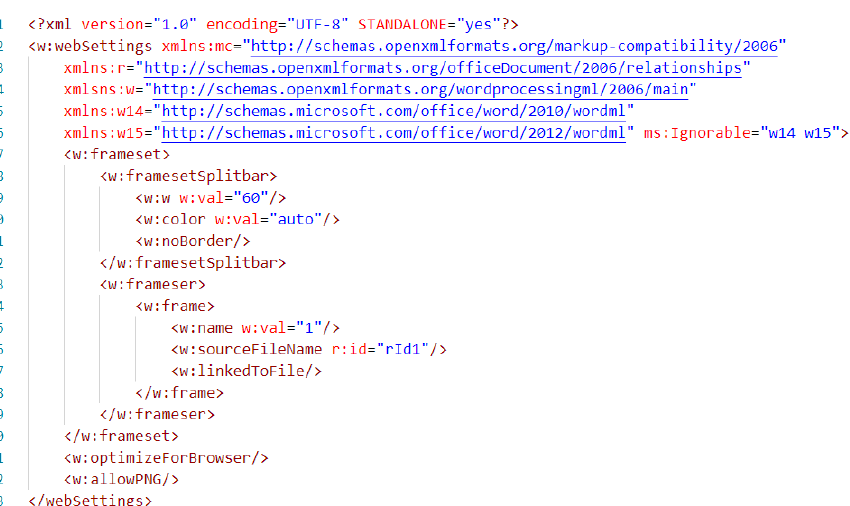
Figure 2. The content of the “word\webSettings.xml” in a DOCX document.